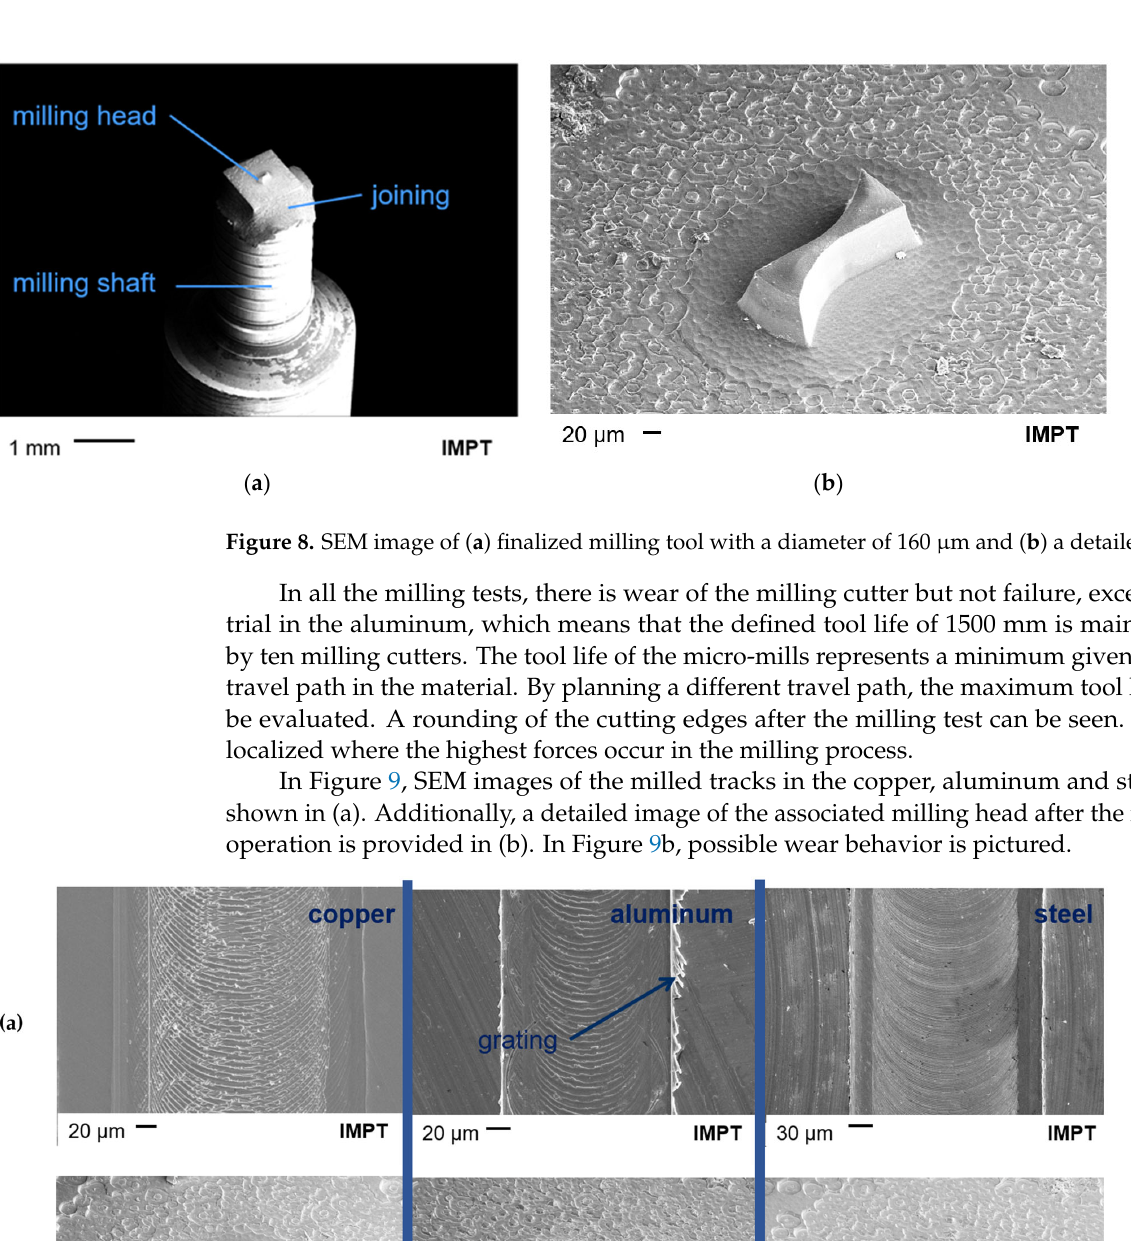
11 of 16 Figure 7. Diced chips on adhesive tape. A manual joining is performed. The curing time of two seconds is held for each cutter. In the tests, shear strengths greater than 10 MPa are consistently maintained. With a test number of ten cutters, an average shear strength of 13.7 ± 1.2 MPa is achieved. The tilt and offset to the center point are examined in CLSM. Both are in the range of 20–30 μ m. With cutter diameters of 200 μ m, this tolerance is acceptable, but with further miniaturization, these tolerances become more influential. This is reflected in a faulty milling track and greater wear. The manually performed joining process can be converted into an auto ‐ mated process with a pick ‐ and ‐ place machine, which may result in reproducible and op ‐ timal properties with regard to planarity and concentricity.